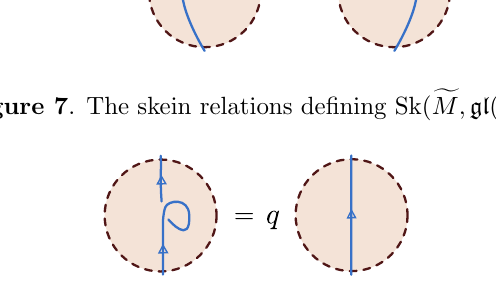
Figure 8 . The change-of-framing relation in Sk( f M; gl